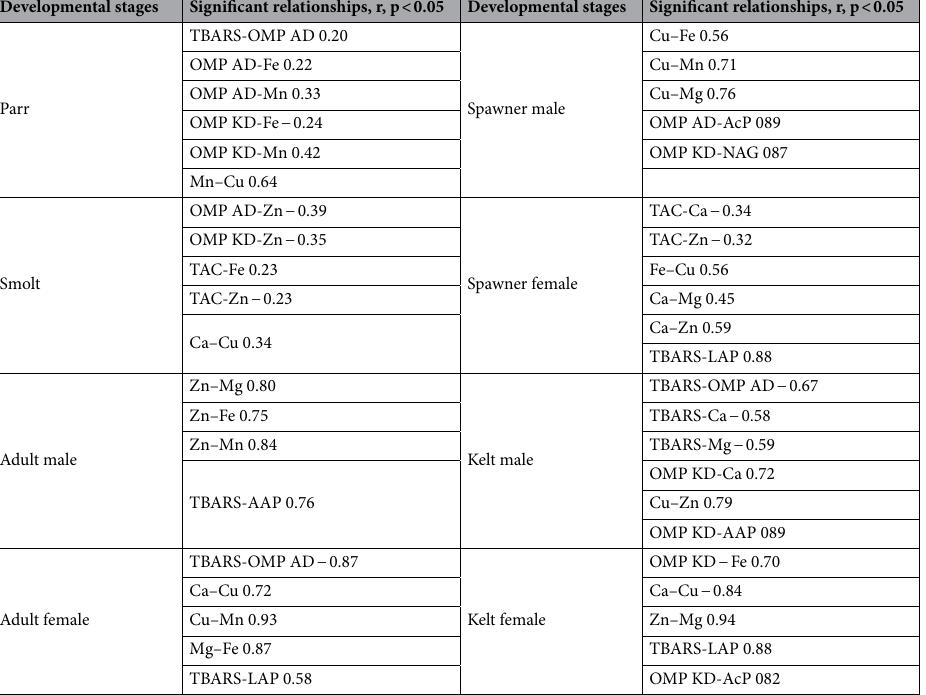
Table 7. Correlation intergroup interdependencies between the parameters of oxidative stress, lysosomes enzymes and elements in the muscle during different development stages of the sea trout.